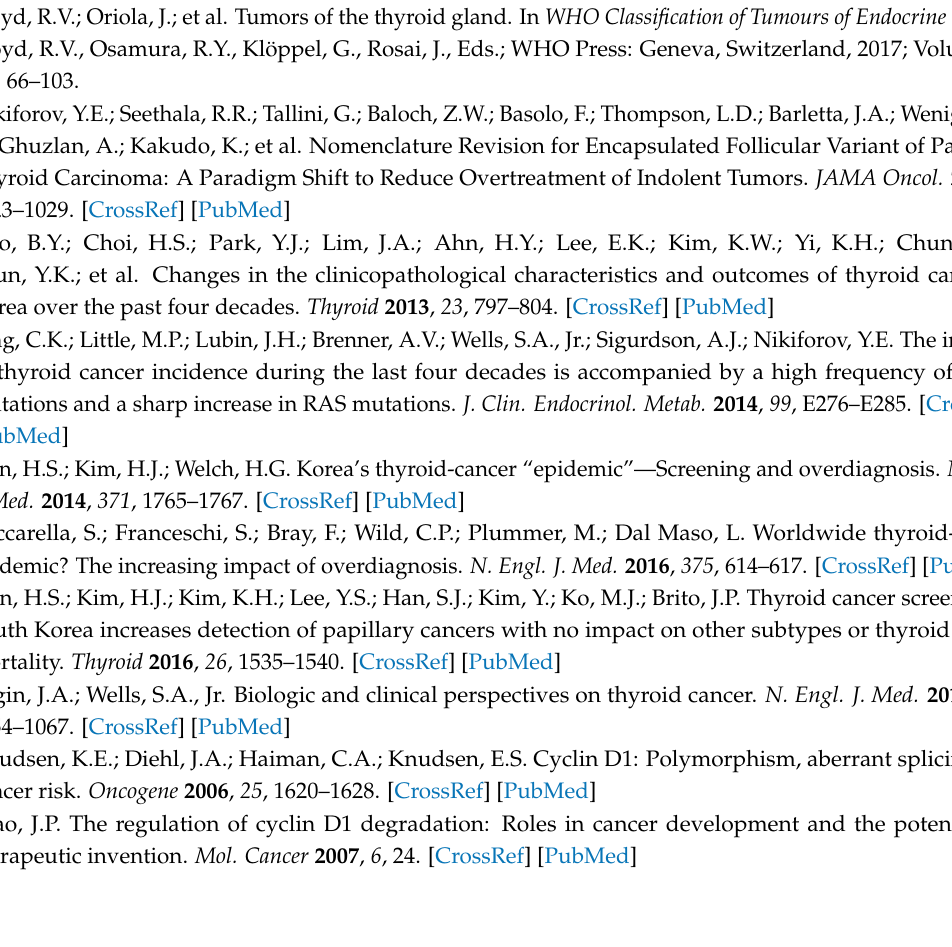
Supplementary Materials: The following are available online at http://www.mdpi.com/2072-6694/10/11/437/ s1, Figure S1: Hürthle cells in Hashimoto’s thyroiditis are positive for cyclin D1a (a, × 400) and negative for cyclin D1b (b, × 400). Most chronic inflammatory cells mixed with Hürthle cells are negative for cyclin D1a and positive for cyclin D1b. Parathyroid cells are positive for cyclin D1a (c, × 400) and negative for cyclin D1b (d, × 400). Figure S2: The rabbit polyclonal cyclin D1b antibody was derived from the intron 4 sequence (VSEGDVPGSLAGAYRGRHLVPRKCRGWCQGPQG). This rabbit polyclonal cyclin D1b antibody was used in Western blot to detect cyclin D1b in two thyroid cancer cell lines, SNU80 (anaplastic thyroid carcinoma) with BRAF G469R mutation and SNU790 (papillary thyroid carcinoma) with BRAF V600E mutation, which were obtained from the Korea Cell Line Bank (Seoul National University, Seoul, Korea). Cyclin D1b runs as a 31 kDa molecule on 10% SDS-PAGE gel. Table S1: Correlation between clinicopathologic features and expression of CCND1 mRNA in The Cancer Genome Atlas (TCGA) dataset of papillary thyroid carcinoma. Table S2: Sequences of primers and probes for the analysis of CCND1 gene. Table S3: Sequences of primers for the molecular analysis of BRAF , NRAS , HRAS , and KRAS genes. Table S4: Rabbit immunization protocol for polyclonal cyclin D1b antibody